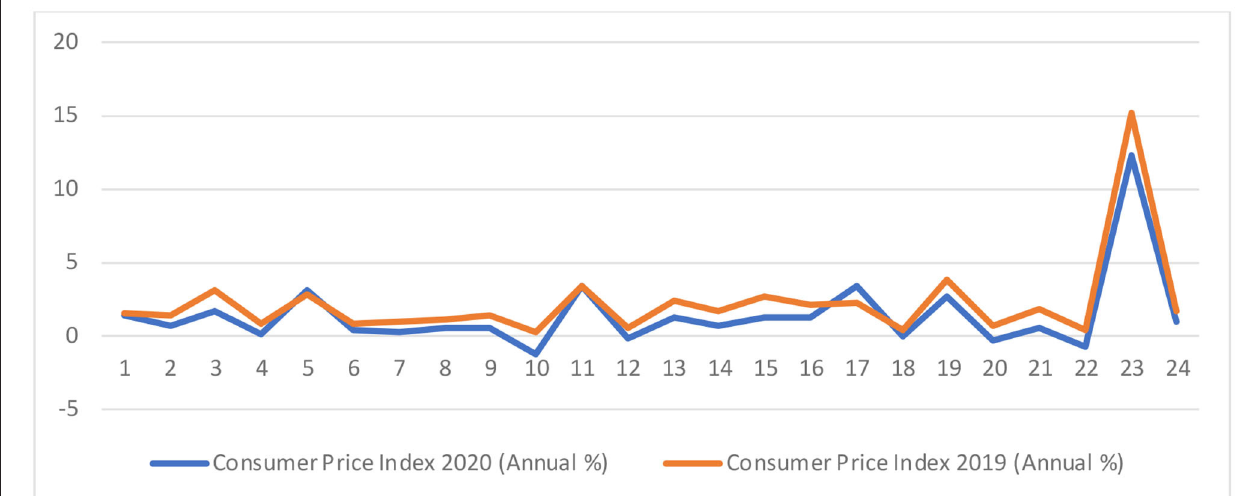
Frontiers in Psychology |